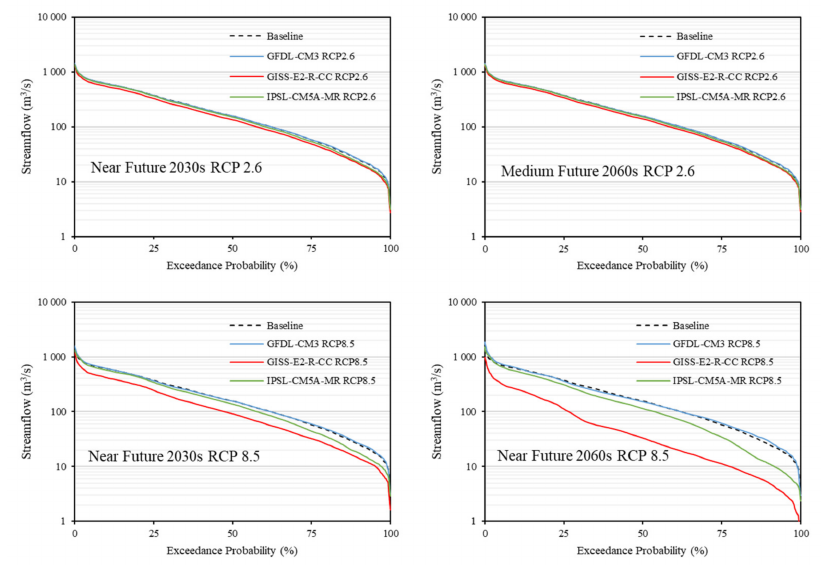
Figure 5. Comparison of flow duration curve at the basin outlet under baseline, RCP 2.6 and RCP 8.5 in the near and medium future.